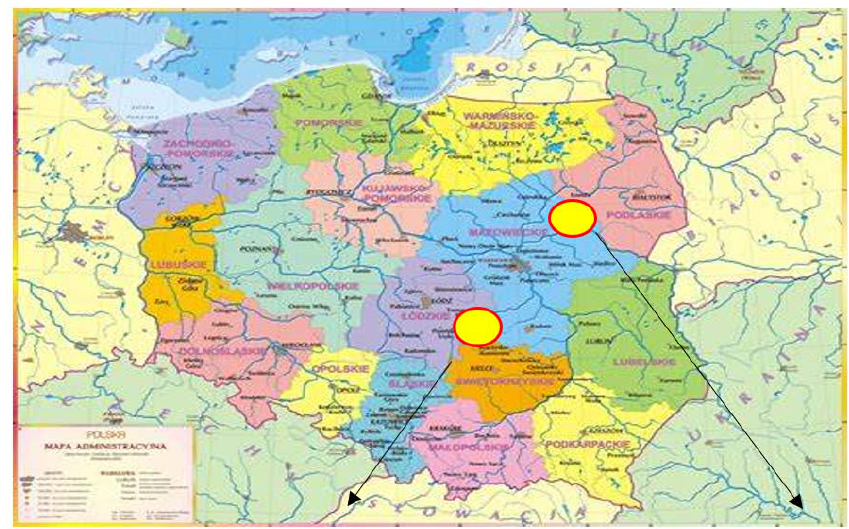
Figure 1. Location of a renewable energy cooperative in Poland. Energy Cooperative in Mszana Eisall Energy Cooperative in Raszyn. Source: own studies.